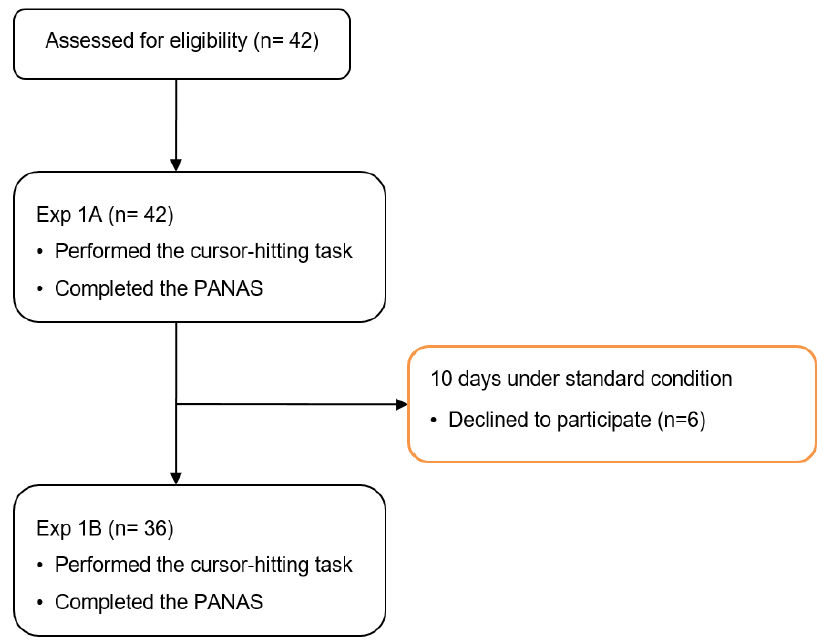
Figure 2. Consort flow diagram of Experiment 1. PANAS, The Positive and Negative Affect Sched- ule.